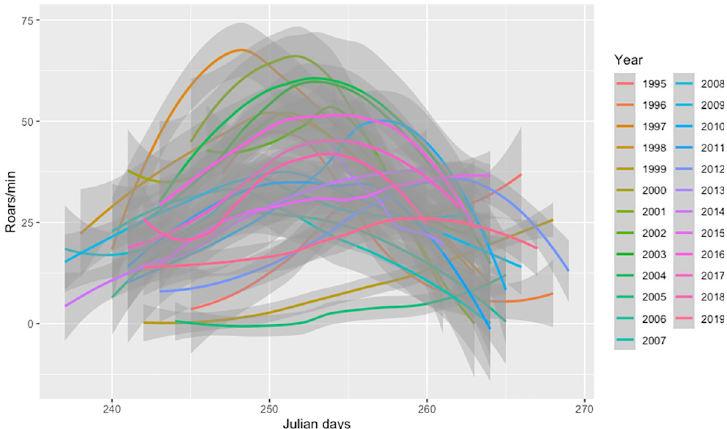
Fig 1. Variation of the roaring rate (roars/min) along the rut period in Julian days. Colours indicate different study years and grey shadows represent confidence intervals (95%). Julian day 250 corresponds to September 7 th .